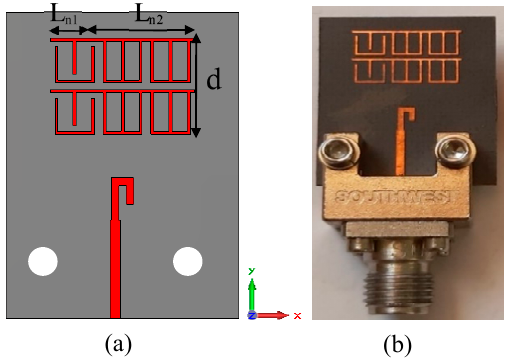
Figure 10. Integration of 2 × 3 MM array with the proposed antenna for positive deflection ( a ) schematic view of MM antenna and ( b ) photo of the fabricated prototype.